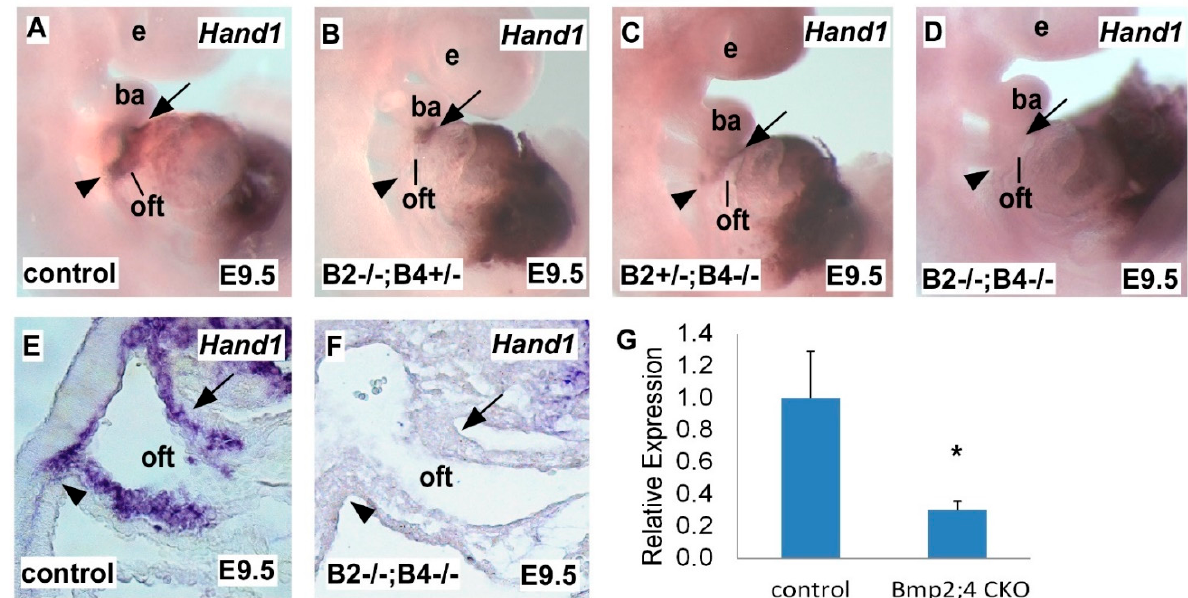
Figure 1. Hand1 expression is regulated by Bmp signaling in a dose-dependent manner during mouse heart development. ( A – D ) Whole-mount in situ hybridization showing Hand1 expression in mouse embryos at E9.5. ( E , F ) E9.5 sagittal sections showed Hand1 in situ hybridization in the branchial arch and OFT. ( G ) qRT-PCR analysis of Hand1 expression in control and Bmp2 / 4 CKO embryos. All genotypes are shown as labeled. B2 − / − ; B4+ / − : Bmp2 homozygous, Bmp4 heterozygous mutants; B2+ / − ; B4 − / − : Bmp4 homozygous, Bmp2 heterozygous mutants; B2 − / − ; B4- / − : Bmp2 / 4 dCKO. e, eye; ba, branchial arch; oft, outflow tract. Arrows and arrow heads point out in situ hybridization signals in OFT and SHF. Data are presented as means ± s.e.m. * indicates p -value < 0.05.